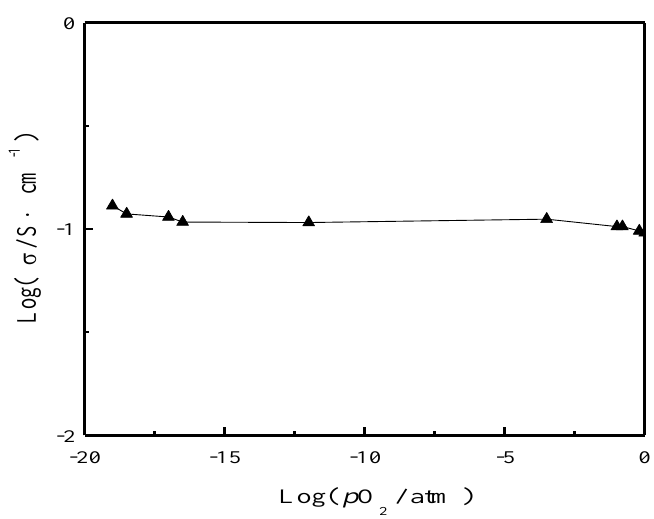
Figure 6. Plot of the conductivity of SrCe 0.9 Sm 0.1 O 3-α -NaCl-KCl (SCS-NK) as a function of p O 2 at 700 °C.